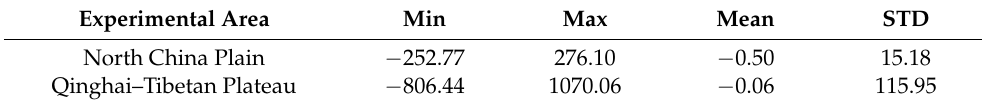
Table 2. Statistics of the UCSD vertical gravity gradient unit: E